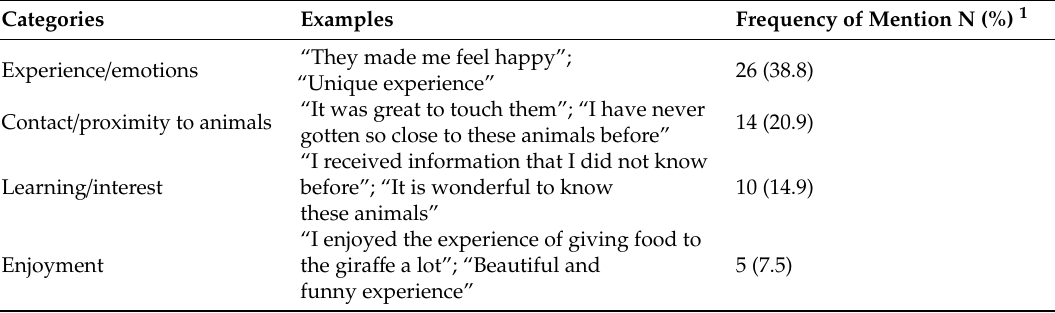
Table 4. Frequency of mention of the categories and examples of the reasons given by the respondents ( N = 55) why the AVI added value to their day at the zoo (in order of frequency).